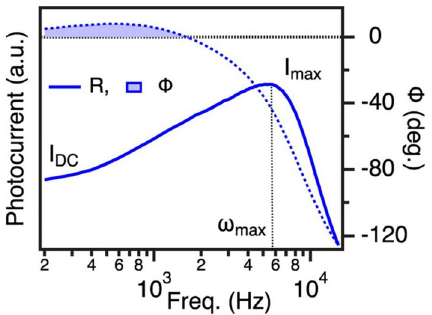
Figure 5. Typical IMPS response characteristics of an organic solar cell showing light degradation. Photocurrent magnitude (R) and phase shift (ϕ) are displayed in the Bode representation. Reprinted with permission from Ref. 57 . Copyright 2020 American Chemical Society.